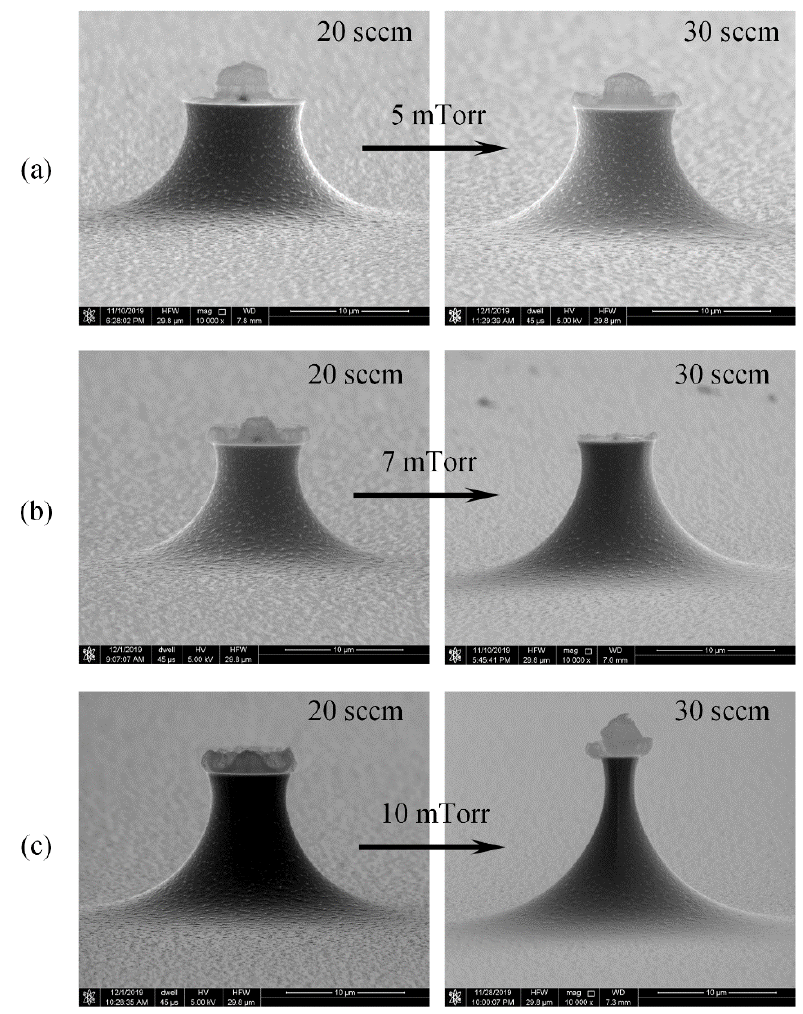
Figure 5. Dependence of tip profile and roughness on SF 6 gas flow rate with 1000 W ICP power and 0 W platen power. ( a ) 5 mTorr, ( b ) 7 mTorr, ( c ) 10 mTorr.